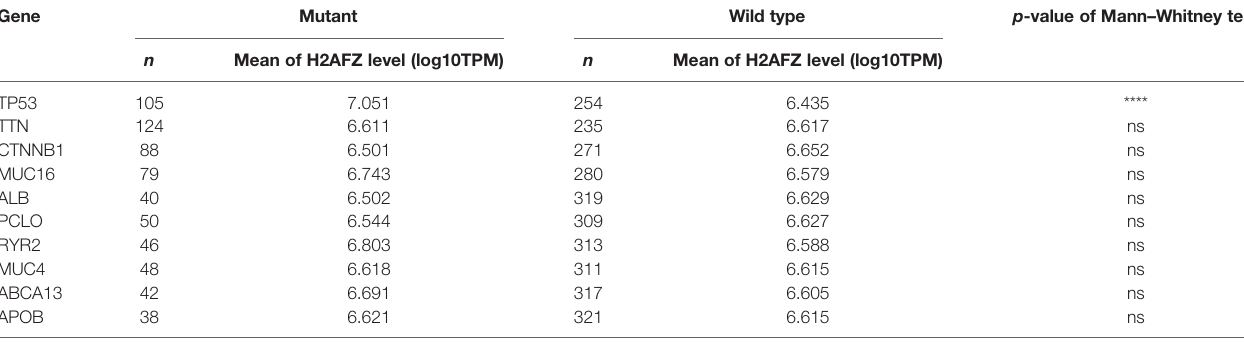
TABLE 1 | Relative expression of H2AFZ in mutants and wild types of TP53, TTN, CTNNB1, MUC16, ALB, PCLO, RYR2, MUC4, ABCA13, and APOB. Gene Mutant Wild type p -value of Mann – Whitney